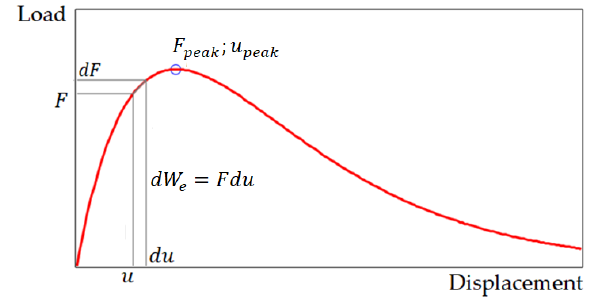
Figure 1. Load–displacement pattern.